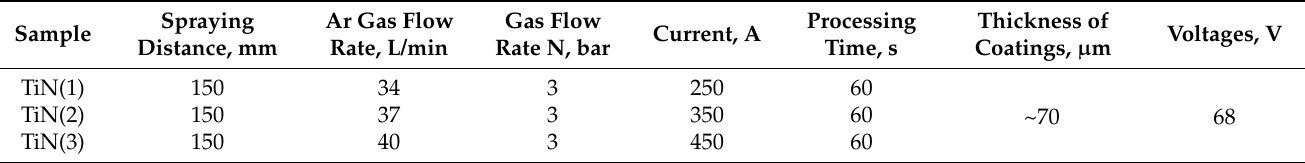
Table 1. Modes of air plasma spraying.